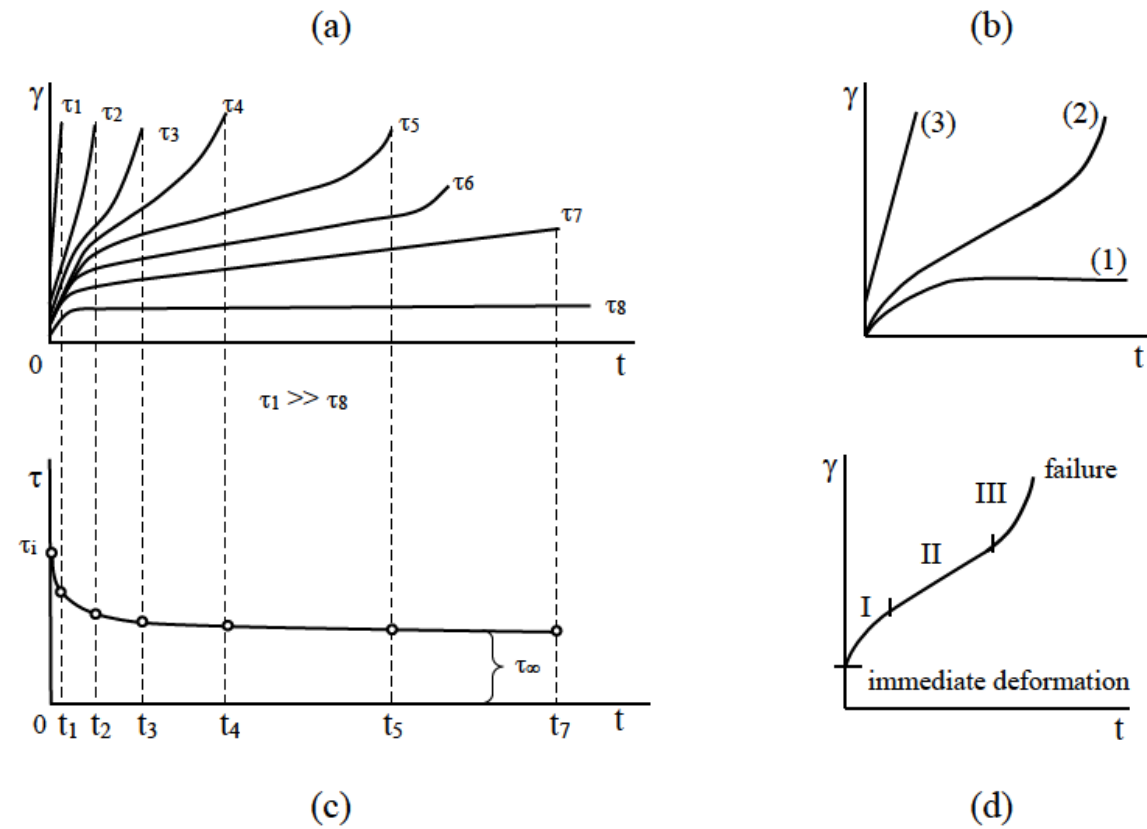
Figure 9: (a) Family of creep curves for a given soil at different constant loads: the higher the load, the faster the failure; (b) Creep curves for different soils at a given load: (1) attenuating or fading creep, (2) accelerated or non-attenuating creep, (3) rapid failure; (c) Long-term strength curve related to creep: where τ ∞ is the ultimate long-term strength and τ i is the instantaneous strength; (d) Stages of creep of accelerated or non-attenuating creep: I – attenuating creep, II – steady-state creep flow, and III – accelerated creep. Modified from [15] and